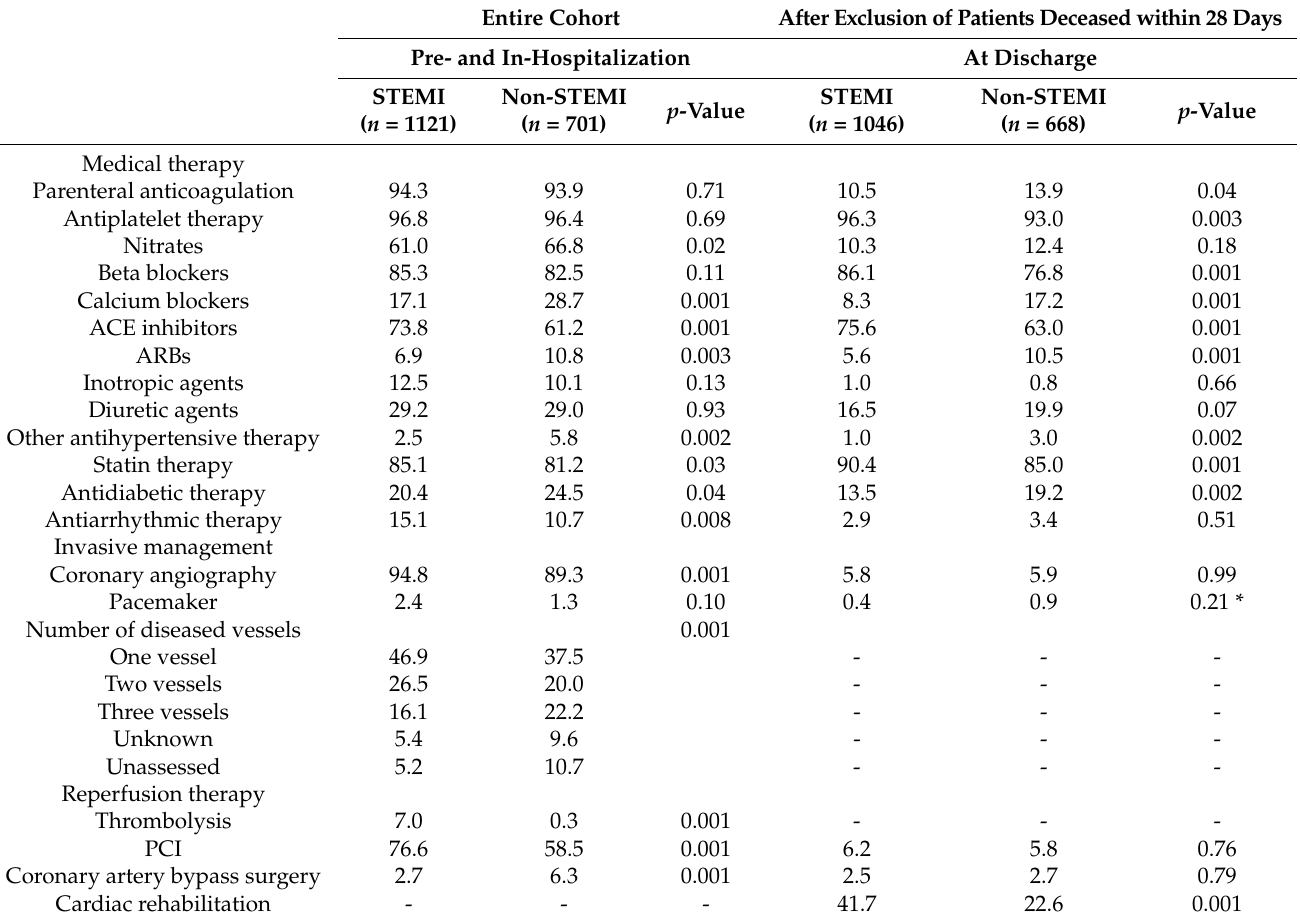
Table 2 provides a description of the therapeutic management and anatomical status according to the type of ACS. The left part of the table presents a comparison of therapeutic management during the pre- and in-hospitalization period and the anatomical status of STEMI and non-STEMI patients, considering the entire cohort. The right part compares the medical therapy prescribed at discharge and strategies of revascularization and cardiac rehabilitation of STEMI and non-STEMI patients and after exclusion of patients